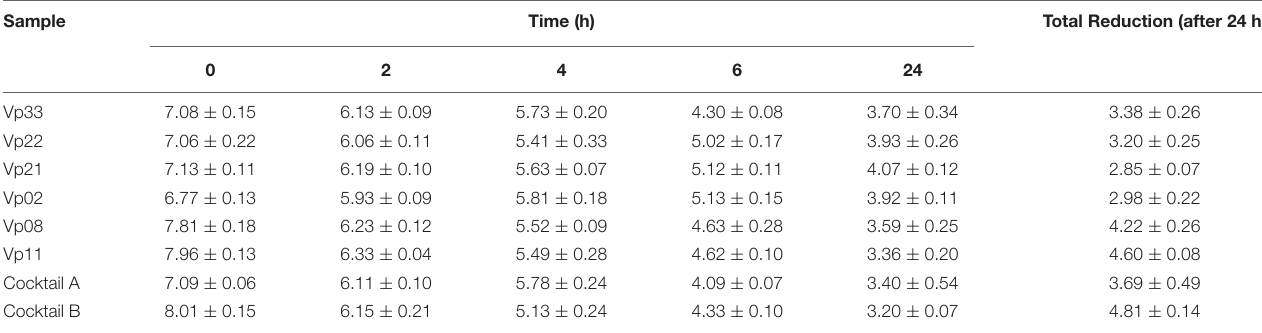
TABLE 6 | Viable count (log CFU/mL) of V. parahaemolyticus after 0, 2, 4, 6, and 24 h incubation at 37 ◦ C with bacteriophage.